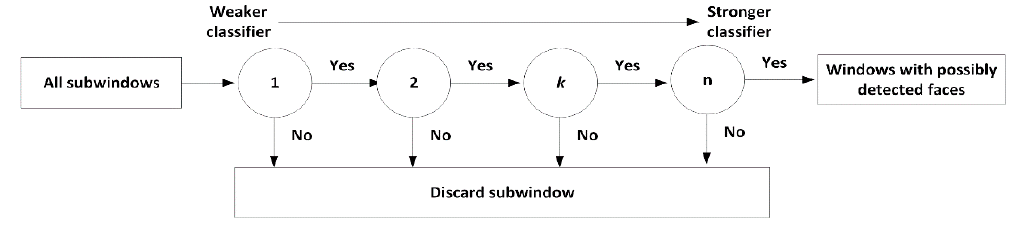
Figure 4. Cascade classifiers in Viola–Jones [40].